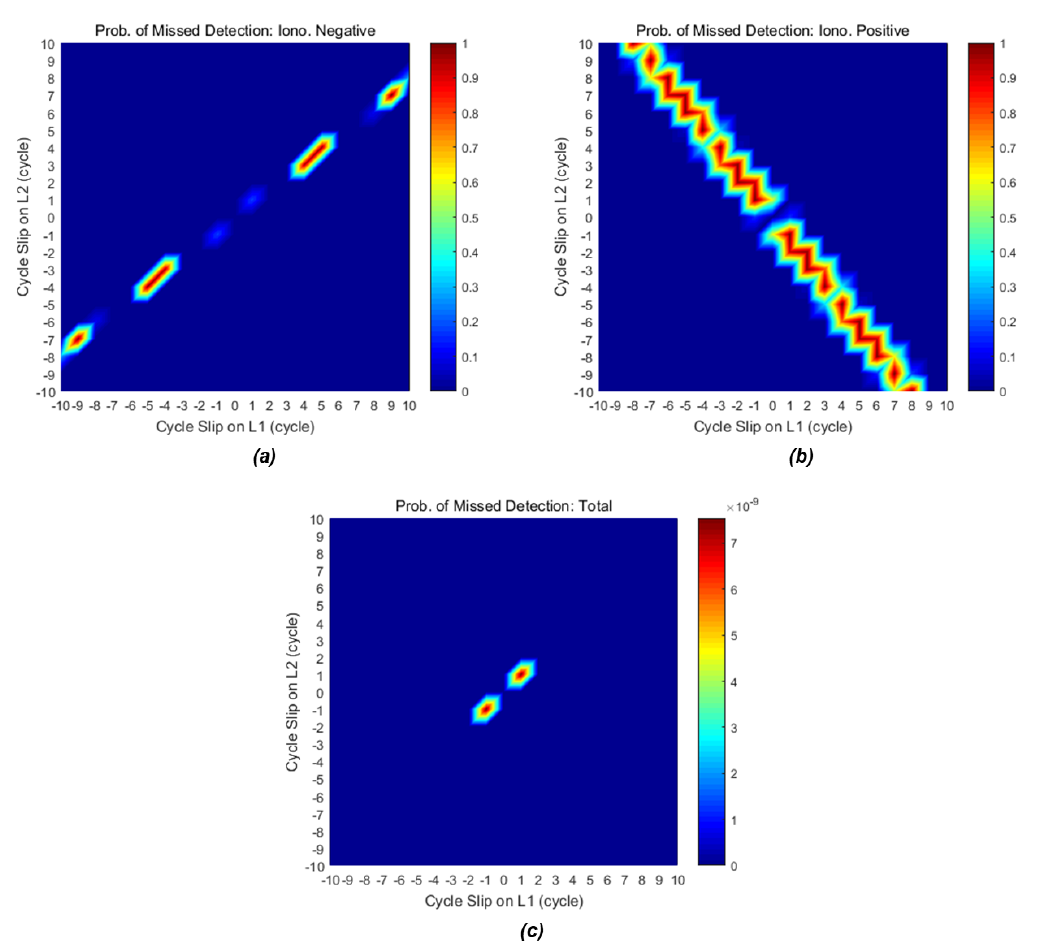
Figure 7. Probability of missed detection for insensitive cycle-slip pairs: ( a ) only the IN combination; ( b ) only the IP combination; ( c ) total probability of missed detection using the two combinations simultaneously. The maximum probability is 7.5 × 10 − 9 when the cycle-slip pair is (1, 1) or ( − 1, − 1). Table 2. Principal insensitive pairs of cycle slip with the probability of missed detection of proposed method (any probability less than 10 − 100 is entered as zero in the table). Cycle Slip Iono. Negative Iono. Positive Total